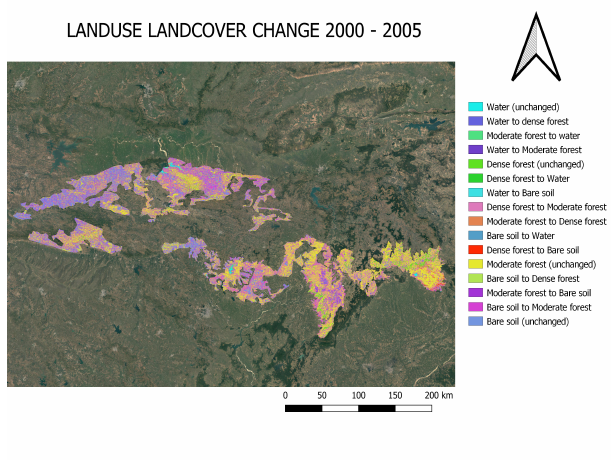
Figure 6: LULC Change 2000 - 2005